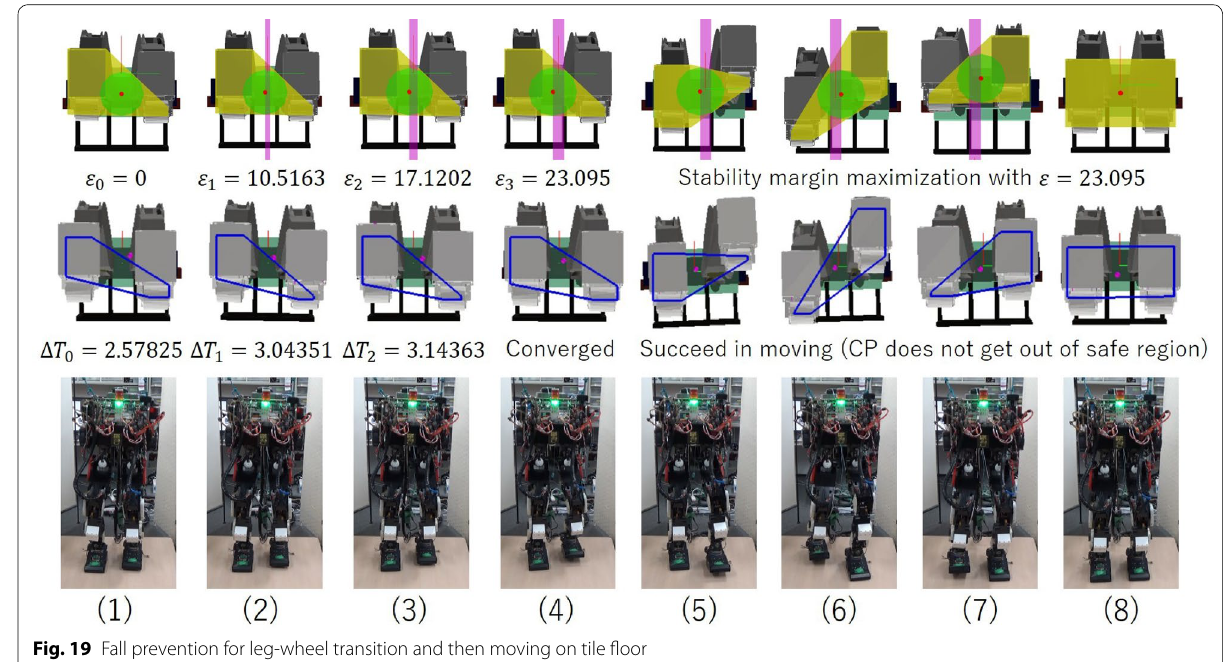
Fig. 19 Fall prevention for leg-wheel transition and then moving on tile floor